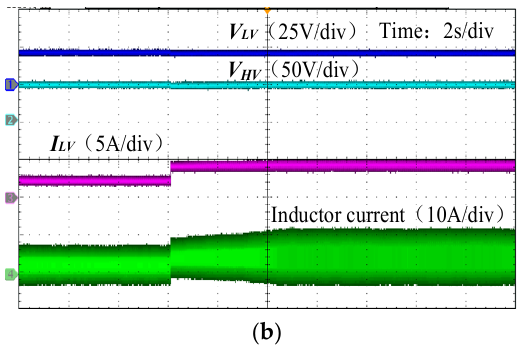
Figure 16. Experimental ZVS waveforms with ( a ) full ‐ load step to half ‐ load step in V LV = 24 V; ( b ) half ‐ load step to full ‐ load step in V LV = 24 V.